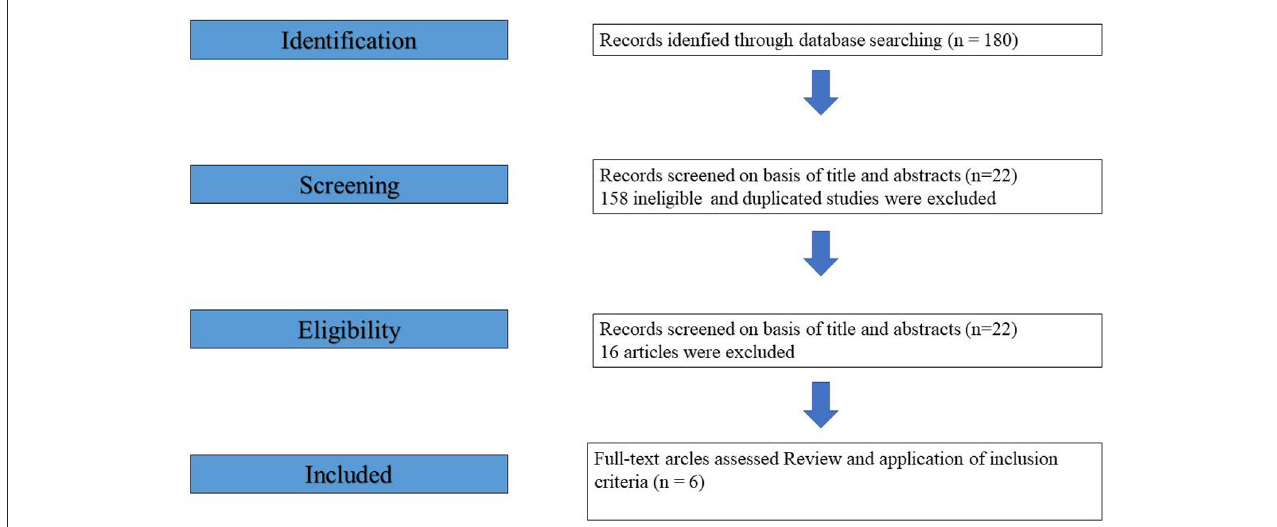
FIGURE1 The PRISMA (Preferred Reporting Items for Systematic Meta-Analyses) flow diagram.